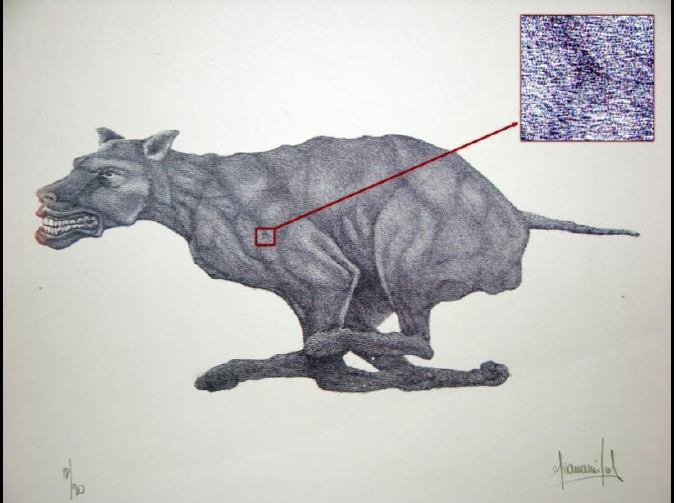
Figure 2. Stone lithography executed by the artist Giovanni Job (Dog